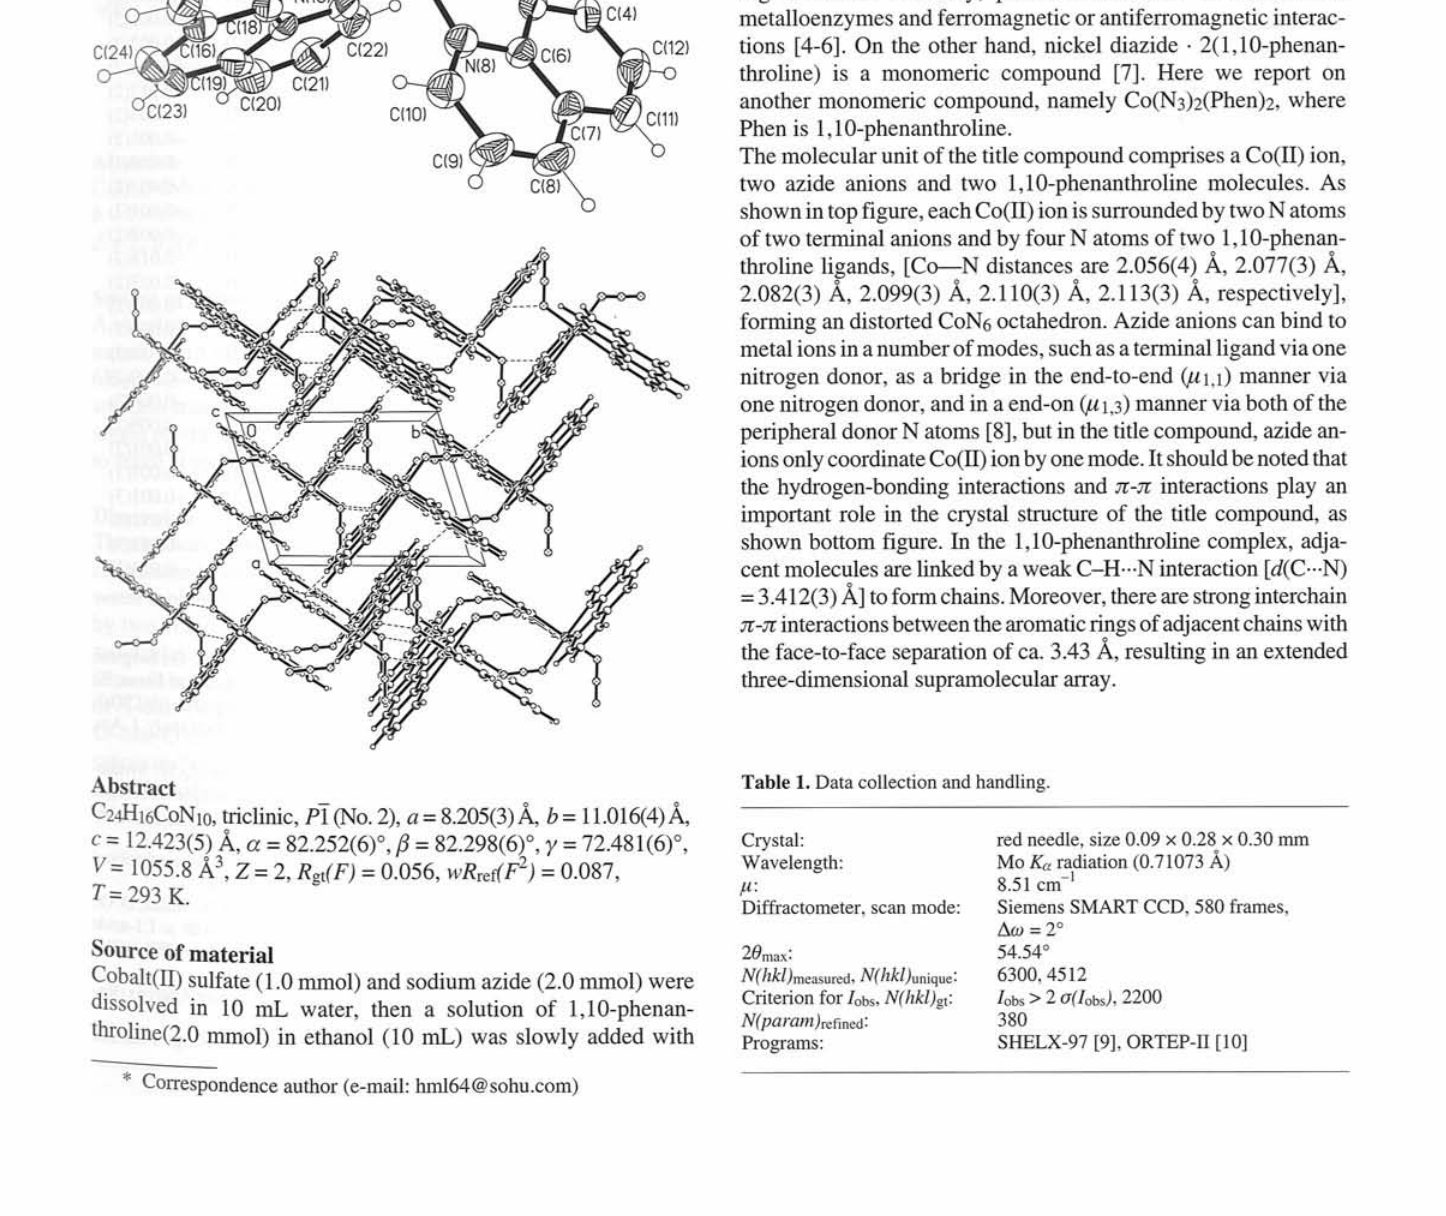
Table 1. Data collection and handling.